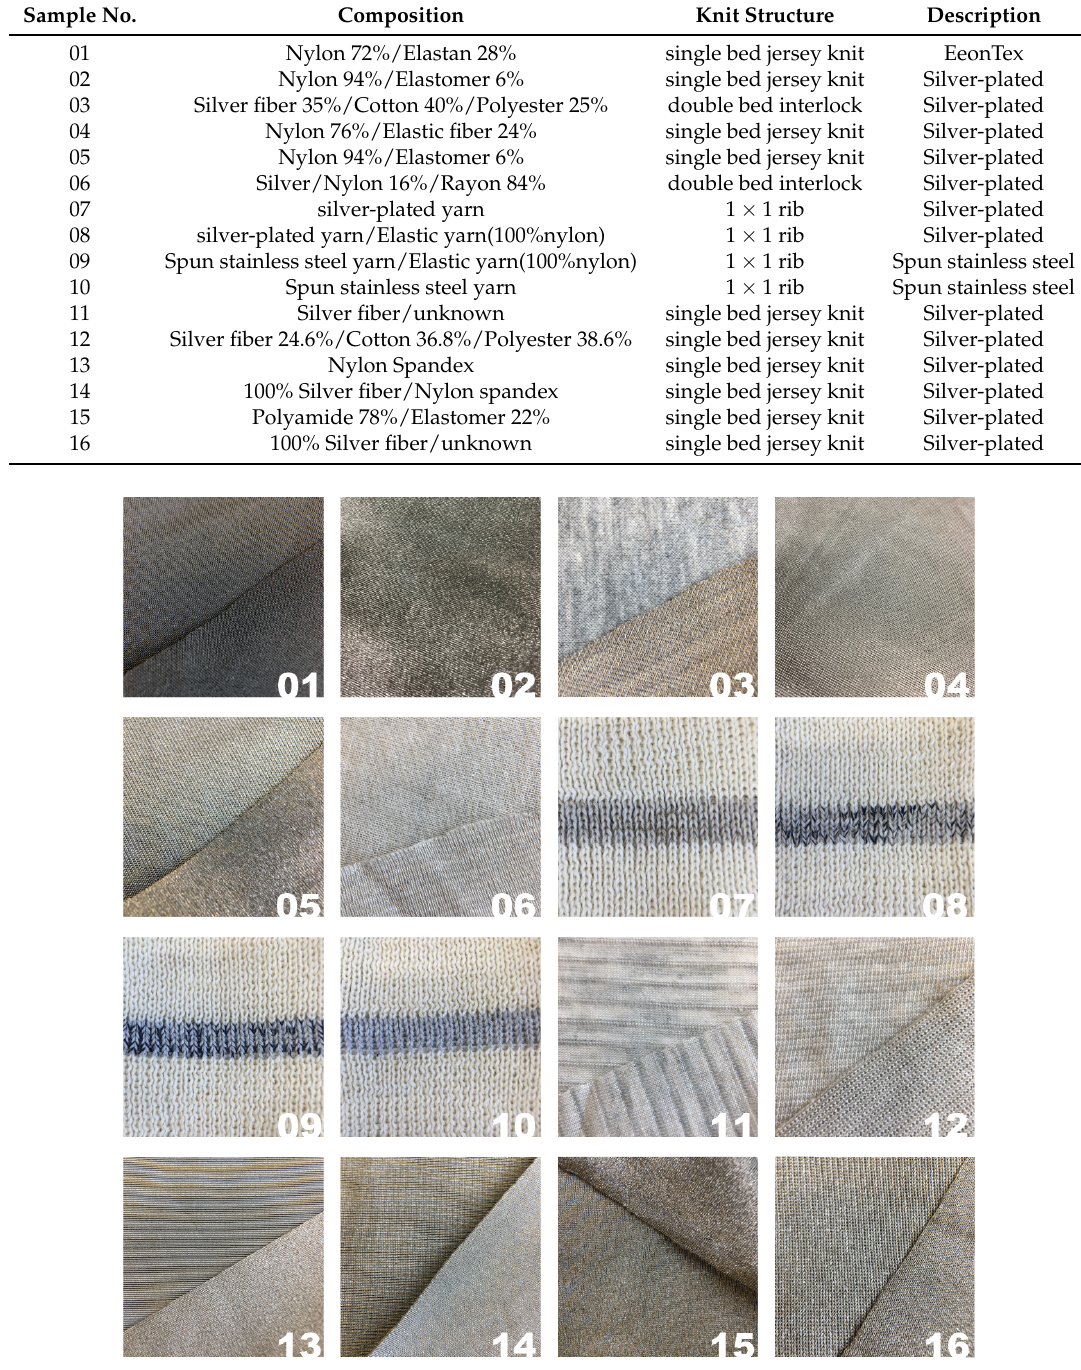
Figure 1. Photographs of the sixteen sensors along with their sensor